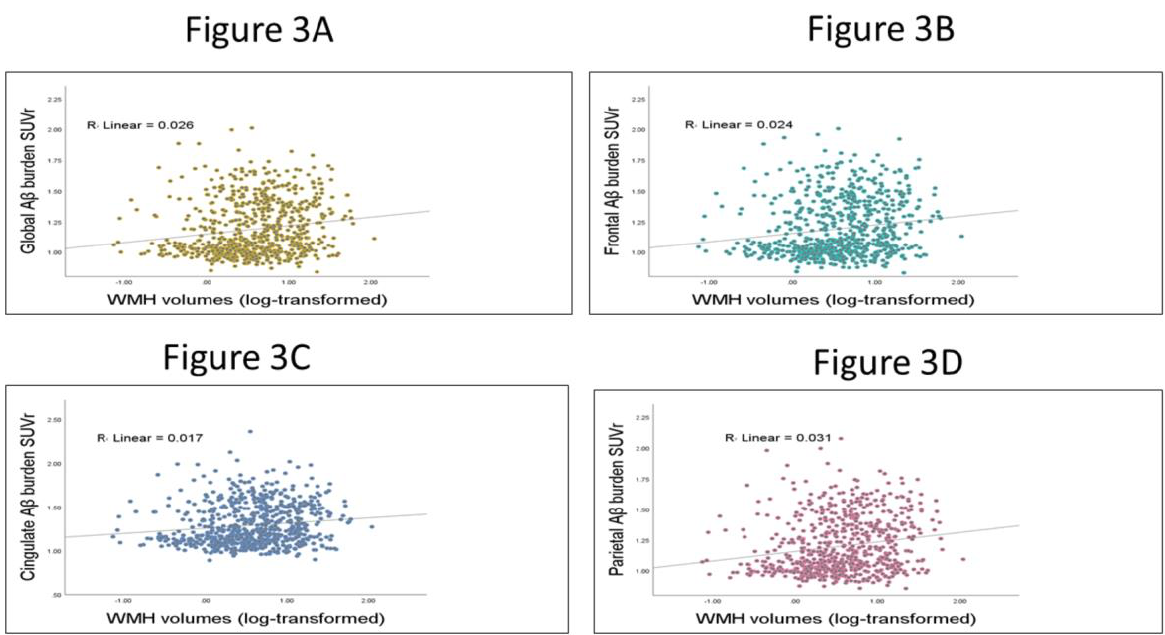
Figure 3. Scatterplot between global and regional Aβ burden and WMH volumes .